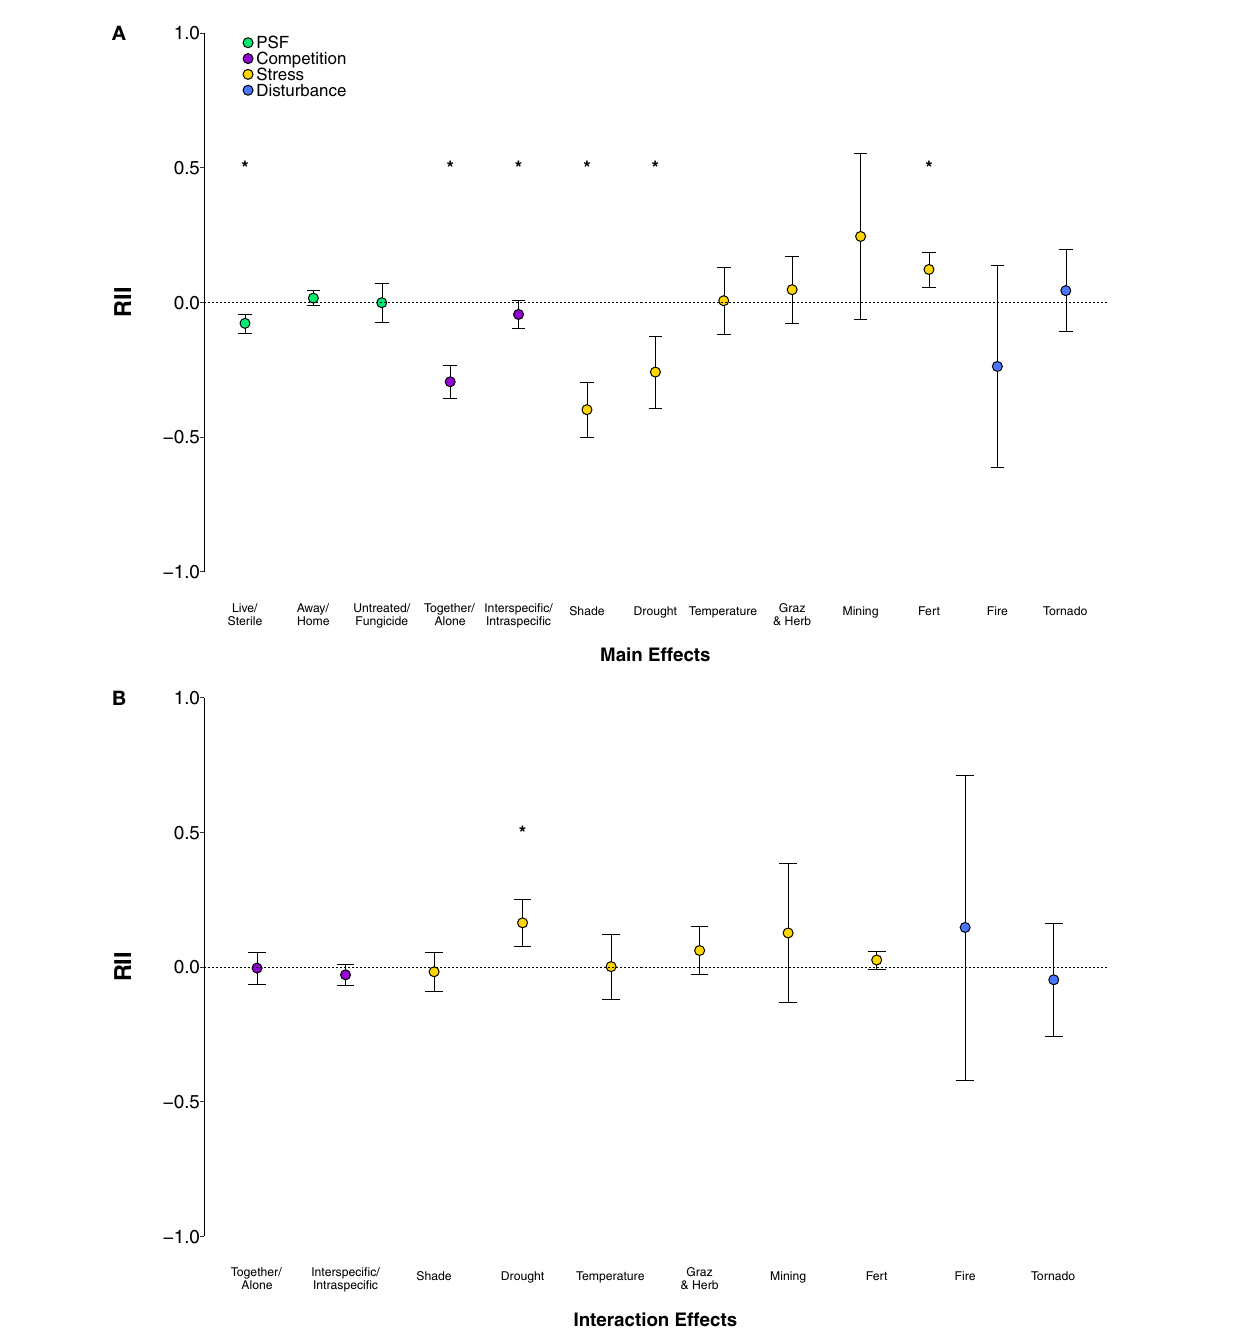
p < 0.001; Table S2 , row 42) and the greenhouse ( Figure 3A ; p < 0.001; Table S2 , row 43), but the effect was 138% stronger in field experiments than greenhouse experiments ( χ 2 p < 0.001; Table S2 , row 122). This trend was driven